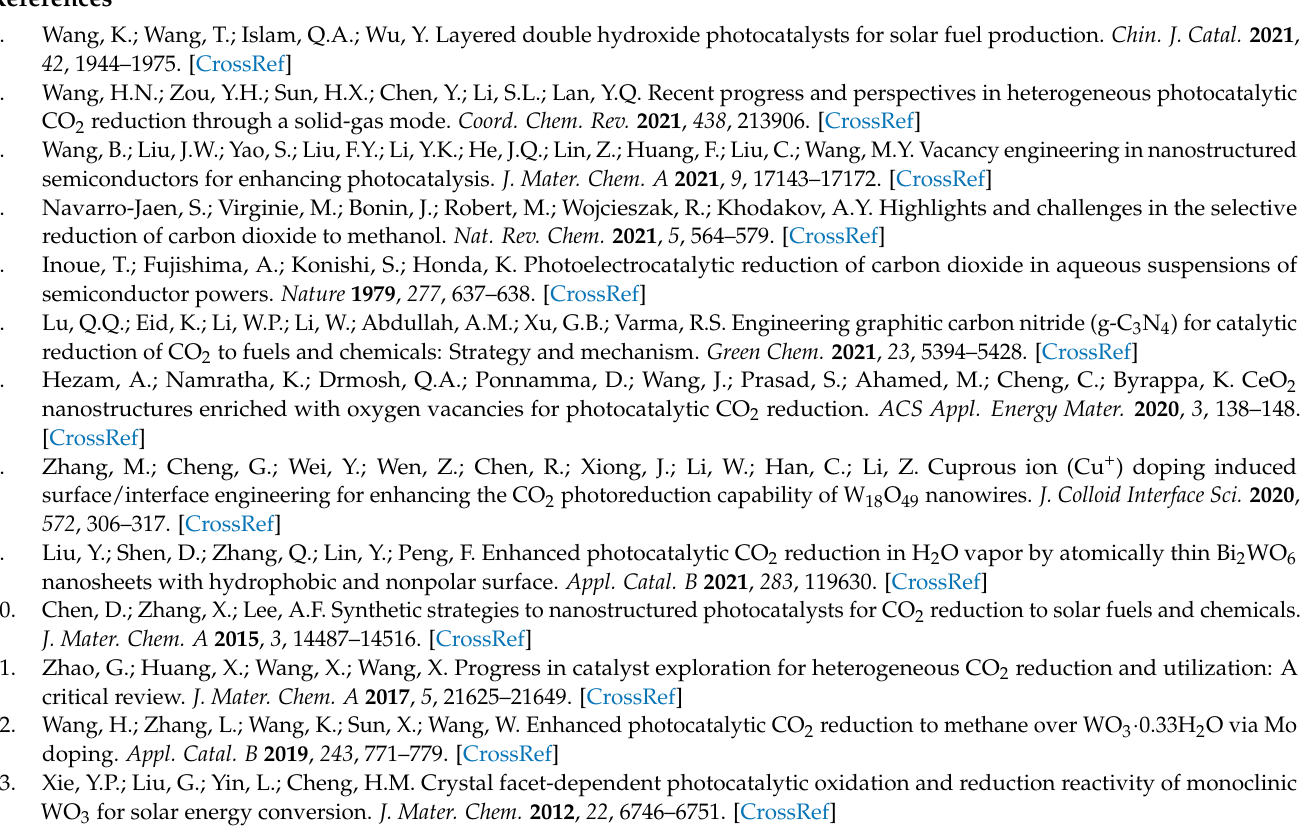
Figure S3. The curves of ( α h ν ) 2 versus photo energy (h ν ); Figure S4. XPS spectra of Cu/Cu 2 O/WO 3 in the cycling